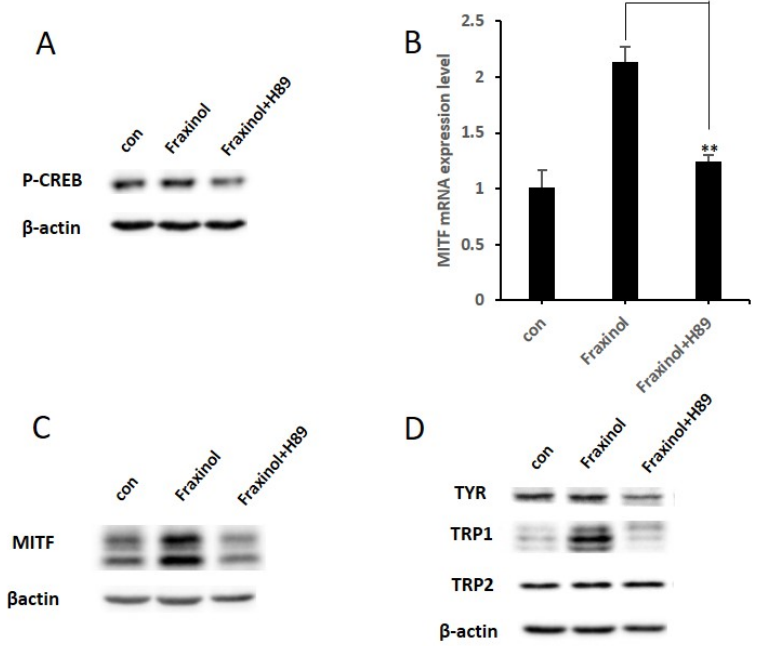
Figure 5. Effects of PKA inhibition on fraxinol ‐ induced phosphorylation of CREB and expression of MITF mRNA and proteins in B16F10 cells. B16 ‐ F10 cells pretreated with or without H89 (10 μ M) for 1 h were stimulated with fraxinol (100 μ M). ( A ) Phosphorylation of CREB was detected at 4 h after fraxinol treatment using western blotting. ( B ) MITF mRNA expression was detected at 12 h after fraxinol treatment using qRT ‐ PCR. ( C ) MITF protein expression was detected at 24 h after fraxinol treatment using western blot analysis. ( D ) Tyrosinase, TRP ‐ 1, and TRP2 protein expression was detected at 48 h after fraxinol treatment using western blotting. The data are presented as the means ± SD; n = 2. ** p < 0.01 compared to the fraxinol ‐ treated group.